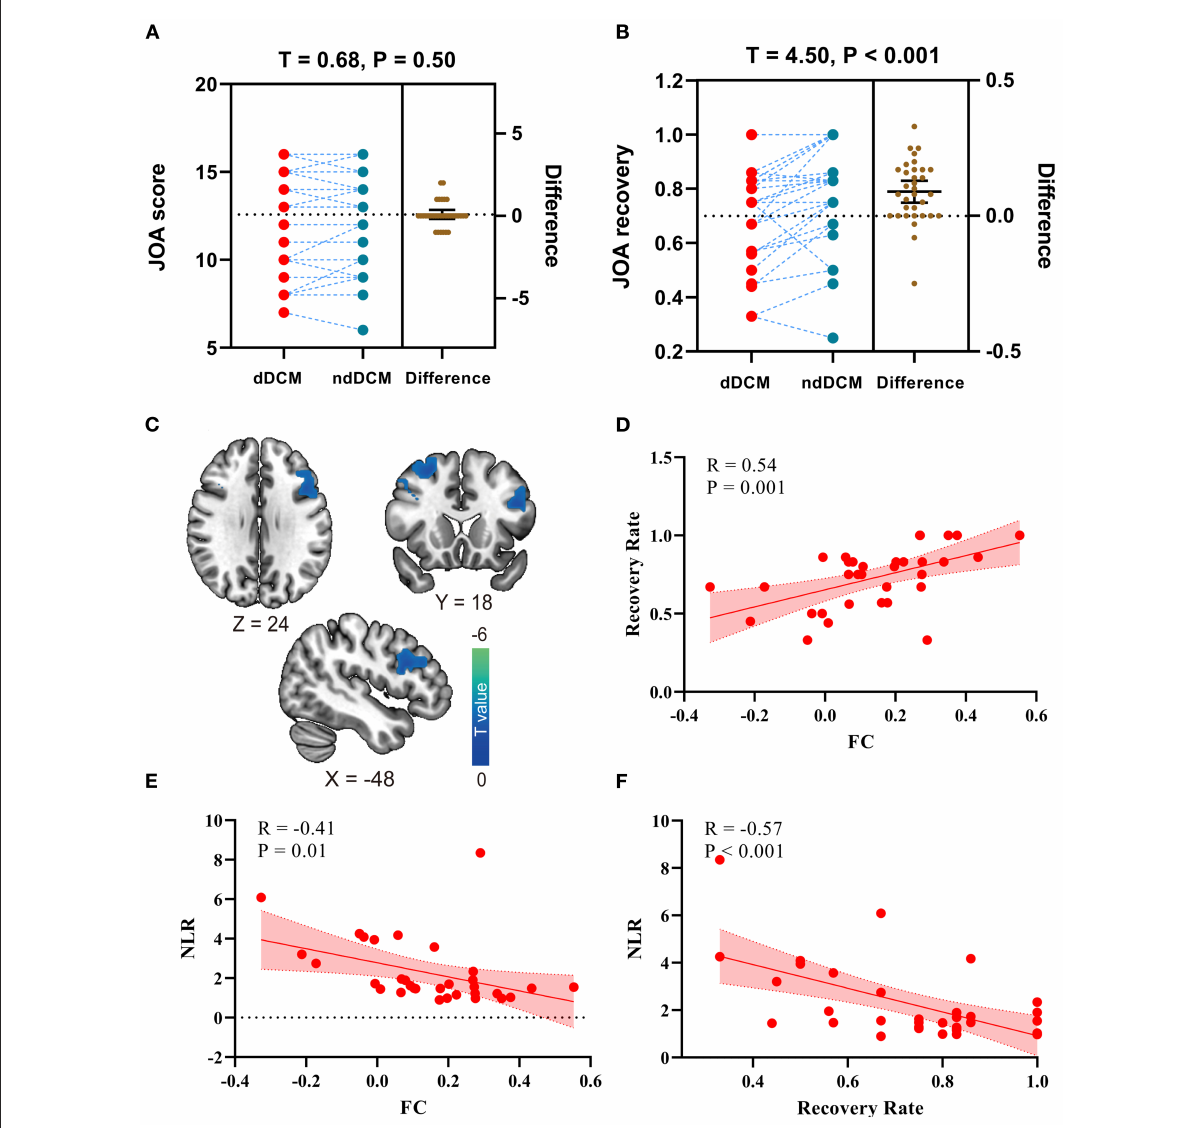
FIGURE2 (A) The preoperative Japanese Orthopedic Association (JOA) score differences in depressed DCM (dDCM) patients and non-depressed DCM (ndDCM) patients; (B) The Japanese Orthopedic Association (JOA) recovery rate differences in depressed DCM (dDCM) patients and non-depressed DCM (ndDCM) patients; (C) Voxel-wise functional connectivity differences between depressed DCM patients and non-depressed DCM patients; (D) The correlation between functional connectivity (FC) and JOA recovery rate; (E) The correlation between FC (between dorsal caudate - inferior frontal operculum) and neutrophils/lymphocyte’s ratio (NLR); (F) The correlation between NLR and JOA recovery rate.